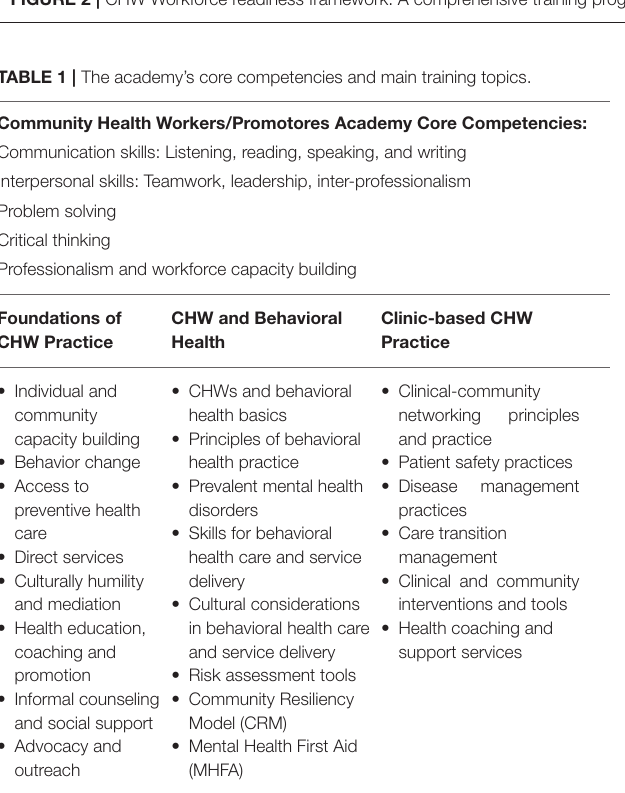
FIGURE 2 | CHW Workforce readiness framework: A comprehensive training program.